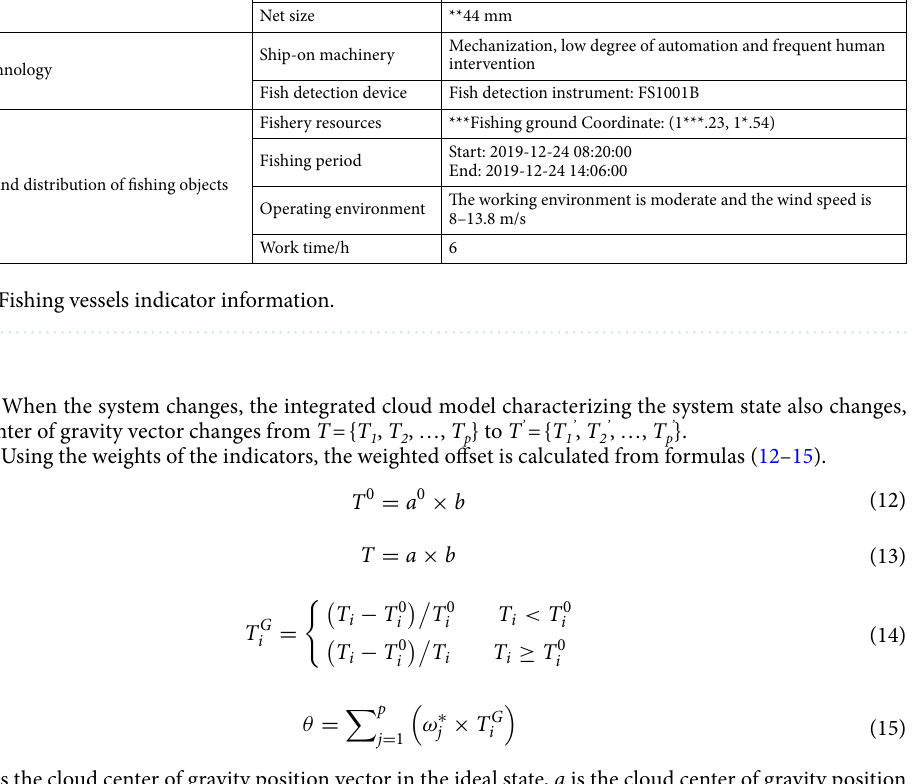
Fish detection device Fish detection instrument: FS1001B